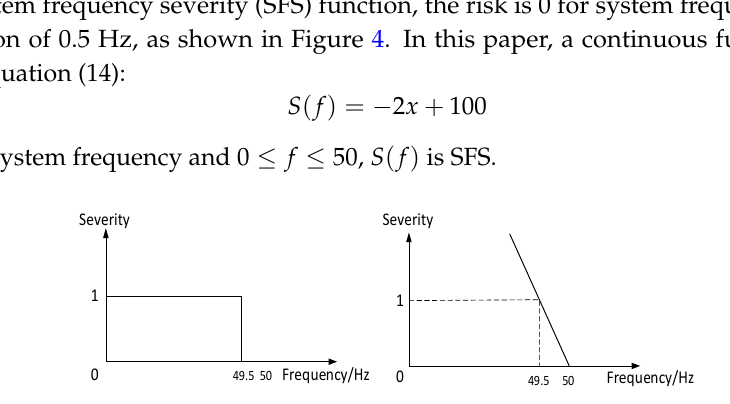
Figure 4. System frequency severity (SFS) function.